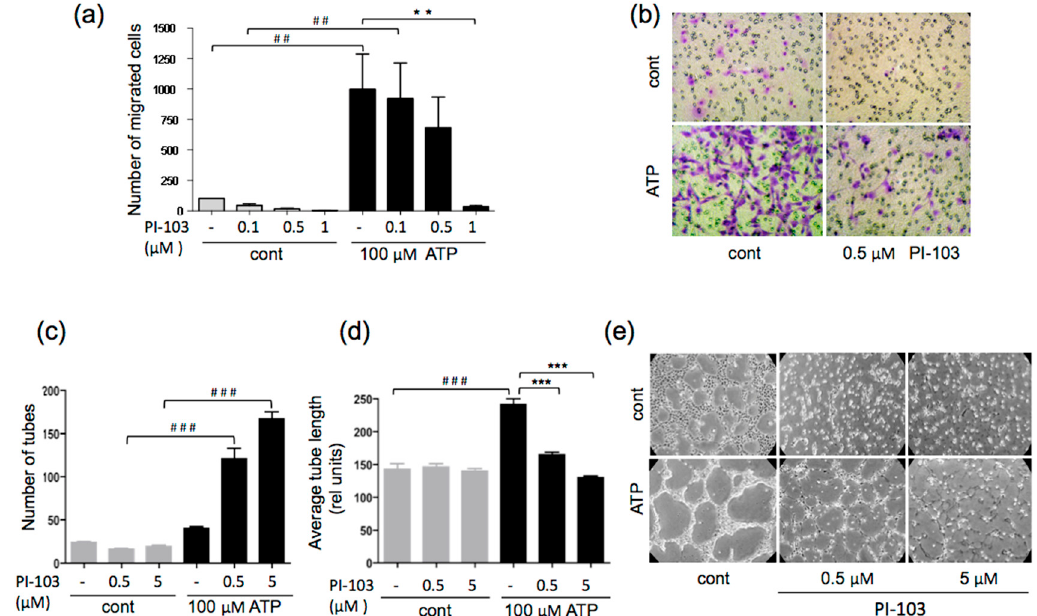
Figure 2. PI-103 inhibits ATP-stimulated migration and tube formation in VVEC. (a) Growth-arrested VVECs were seeded in Boyden chambers and remained untreated or were pretreated with PI-103 for 1 h, followed by adding ATP to the lower transwell compartment to initiate migration (100 µ M). Migrated cells were counted at the end of the experiment, after 24 h. Shown are the data from four independent experiments (n = 4) conducted on four distinct VVEC populations; values are means ± SEM; ## p < 0.01, ATP-untreated vs. ATP-treated; ** p < 0.01, PI-103-untreated vs. PI-103-treated. (b) Representative membrane filters with migrated cells, stained with crystal violet. (c, d) VVEC were plated on Growth Factor Reduced Matrigel as described in the Materials and Methods Section. Cells were untreated or pretreated with PI-103 (0.5 and 5 µ M) for 1 h and stimulated with ATP (100 µ M). Tube formation was assessed after 8 h incubation. Shown are number of tubes and average tube length from five independent experiments (n = 5) performed on three distinct VVEC populations; values are means ± SEM; ### p < 0.001 ATP-untreated vs. ATP -treated; *** p < 0.05 PI-103-untreated vs. PI-103-treated. (e) VVEC tube formation images from a representative experiment; p < 0.05 was considered significant (Panels a, c, d: one-way analysis of variance followed by Bonferroni post-test).